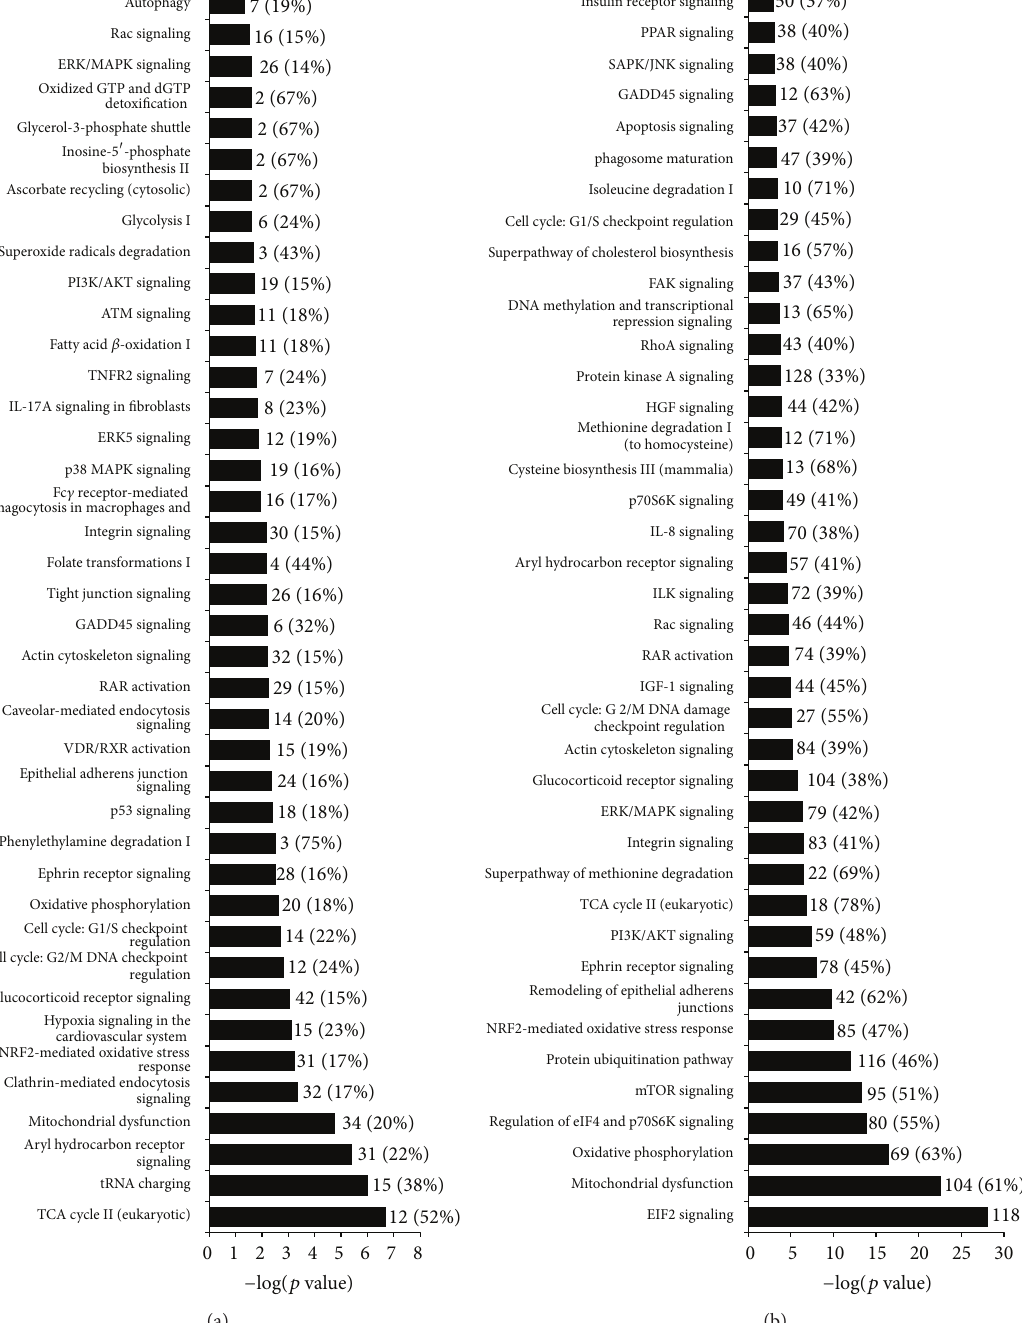
Figure 3: IPA analysis of differentially expressed host genes in VACV-infected cells. The list of SDEGs identified after VACV infection was used in a pathway enrichment analysis with IPA software. The 40 most significant pathways identified at 4hpi (a) and 9hpi (b) after VACV infection are shown. The 𝑥 -axis represents the 𝑝 value, indicating the significance of enrichment for the corresponding gene set. The values are plotted in a negative log 10